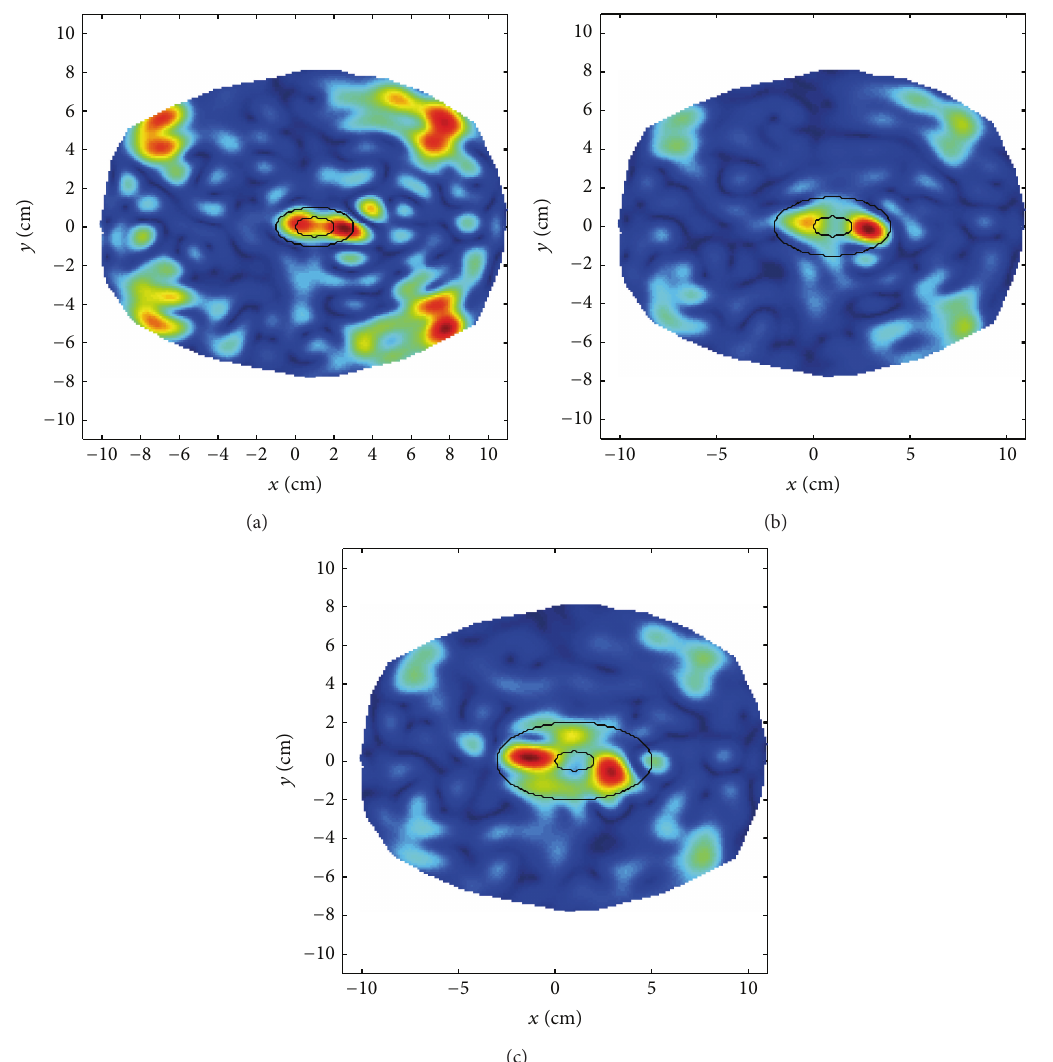
Figure 4: Assessment of the role played by the inaccurate positioning of the device between the two measurement time instants (noiseless data). The actual reference scenario is assumed to build the inversion kernel. The images report the normalized amplitude of the differential contrast as retrieved from (4), so that red areas mark the portion of the head where changes are occurring.